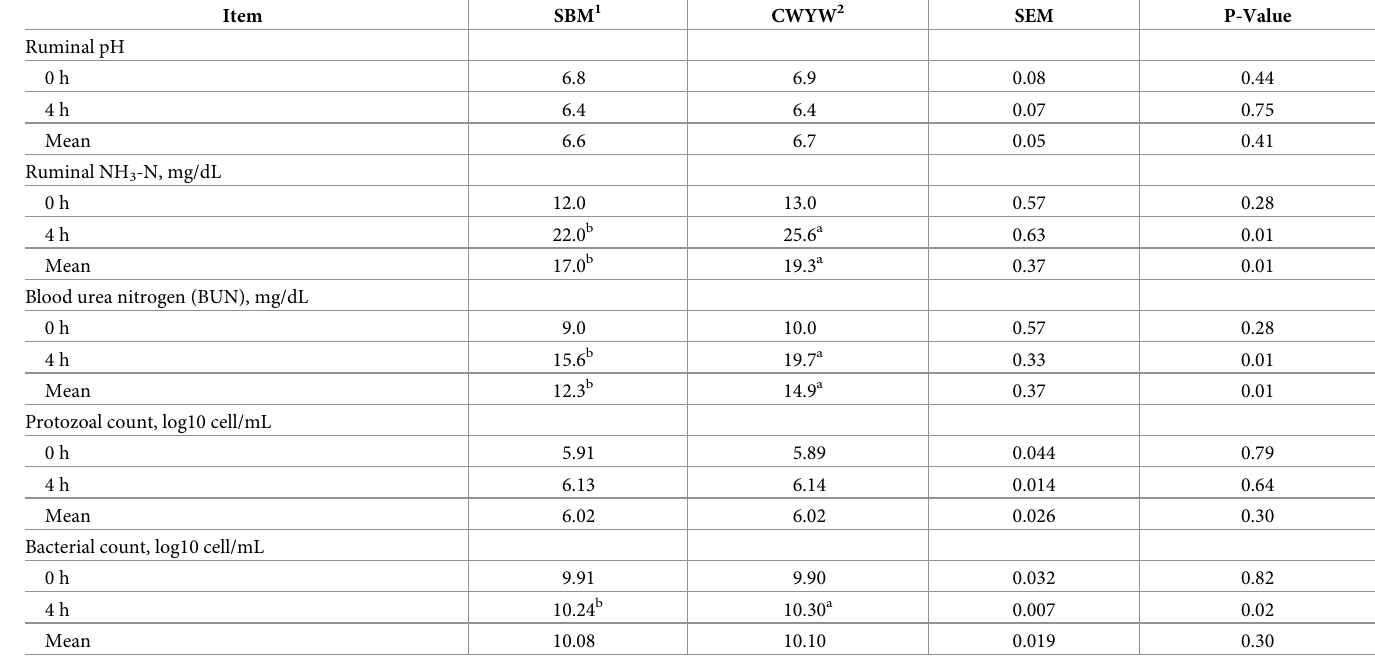
Table 3. Effect of replacing soybean meal with citric waste fermented yeast waste on ruminal ecology and blood urea nitrogen. Item SBM 1 CWYW 2 SEM Ruminal pH